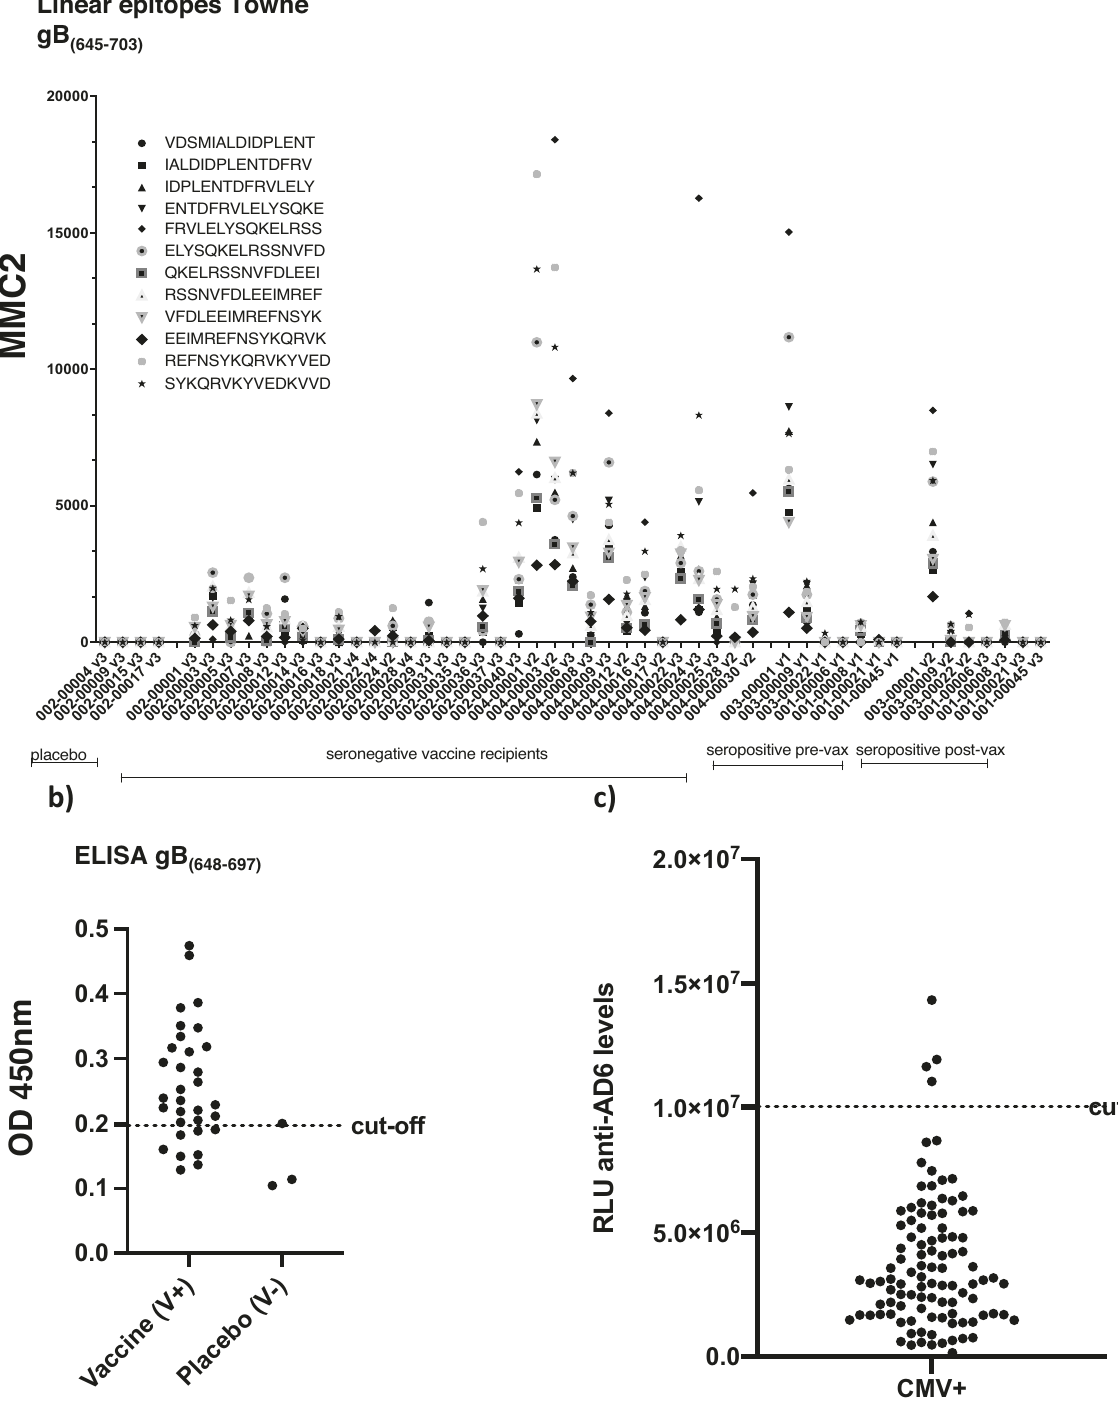
Towne)in32seronegativerecipientsofvaccine(V+)or3placebo(V − )measuredby ELISA and represented as absorbance at 450mm. Cutoff calculated as average of 2seronegative seraplus 4 standard deviations. c Anti-AD-6 IgG (gB (648 – 697) Towne) levels in 102 CMV seropositive volunteers measured by chemiluminescence immunoassay (CLIA). Cutoff was determined by averaging values of seven sera samples from CMV seronegative volunteers plus 4 standard deviations. Values are expressed as relative light units